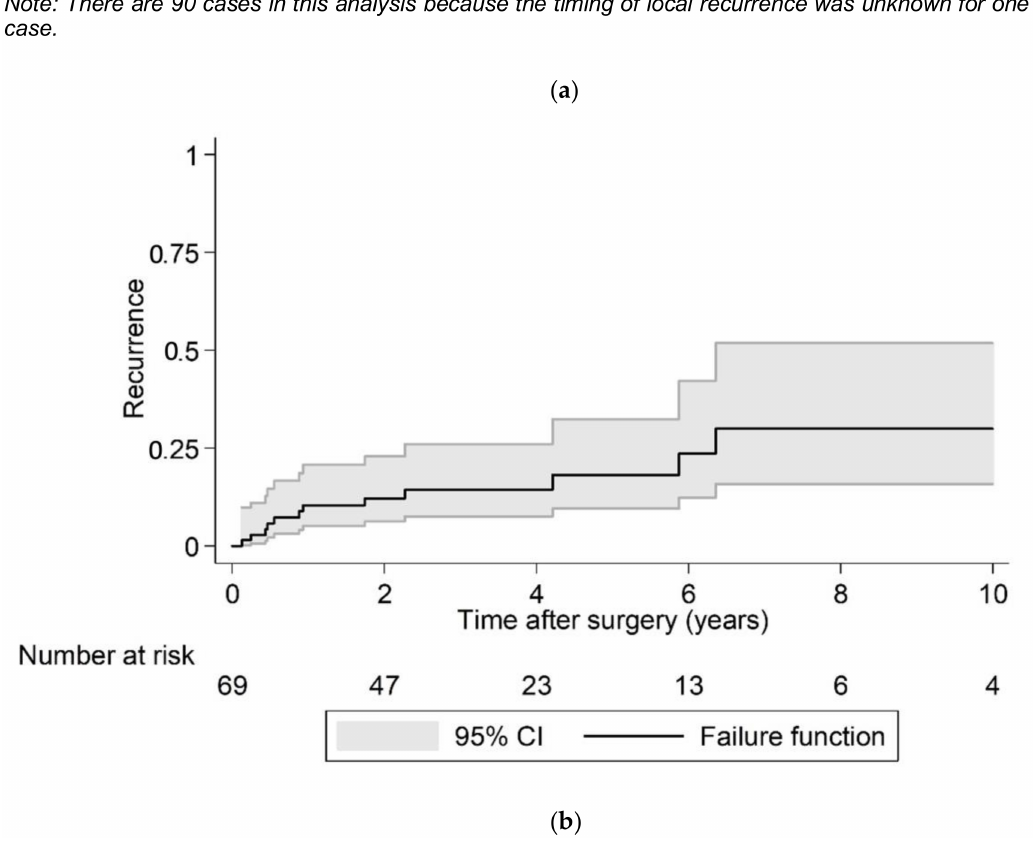
Figure 2. Kaplan–Meier curves of time to first local recurrence following surgery for less aggressive entities ( a ) and GCT/OBL patients ( b